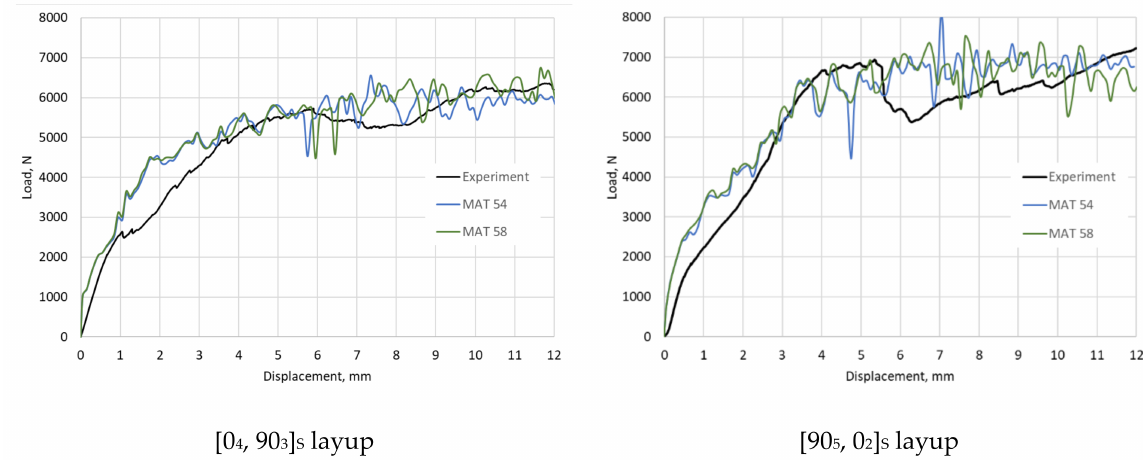
Figure 11. Force–displacement diagrams: experiment vs. numerical